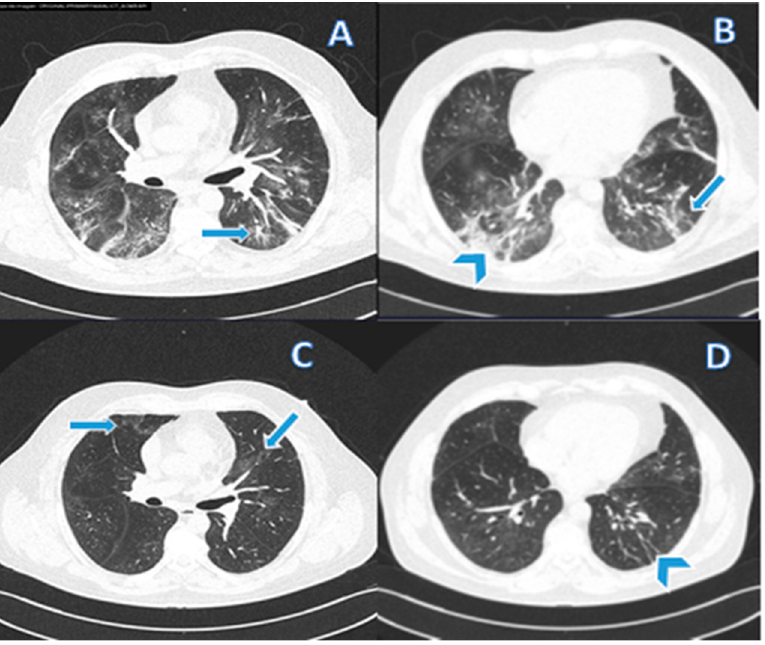
Figure 3. ( A ) and ( B ) CT from a 56-year-old male patient in the active infection phase of COVID-19. ( C ) and ( D ) CT after six months of infection resolution. Typical findings of COVID-19 pneumonia and tomographic findings that support the diagnosis of pulmonary fibrosis are observed. ( A ) Vascular thickening (arrow) associated with an area of ground-glass opacity; ( B ) Subpleural parenchymal bands (arrows) and ground-glass opacity and consolidation (arrowheads); ( C ) Absorption of most of the affected areas leaving some lesions in ground glass; and ( D ) Fibrous lesions that represent residual organizing pneumonia.